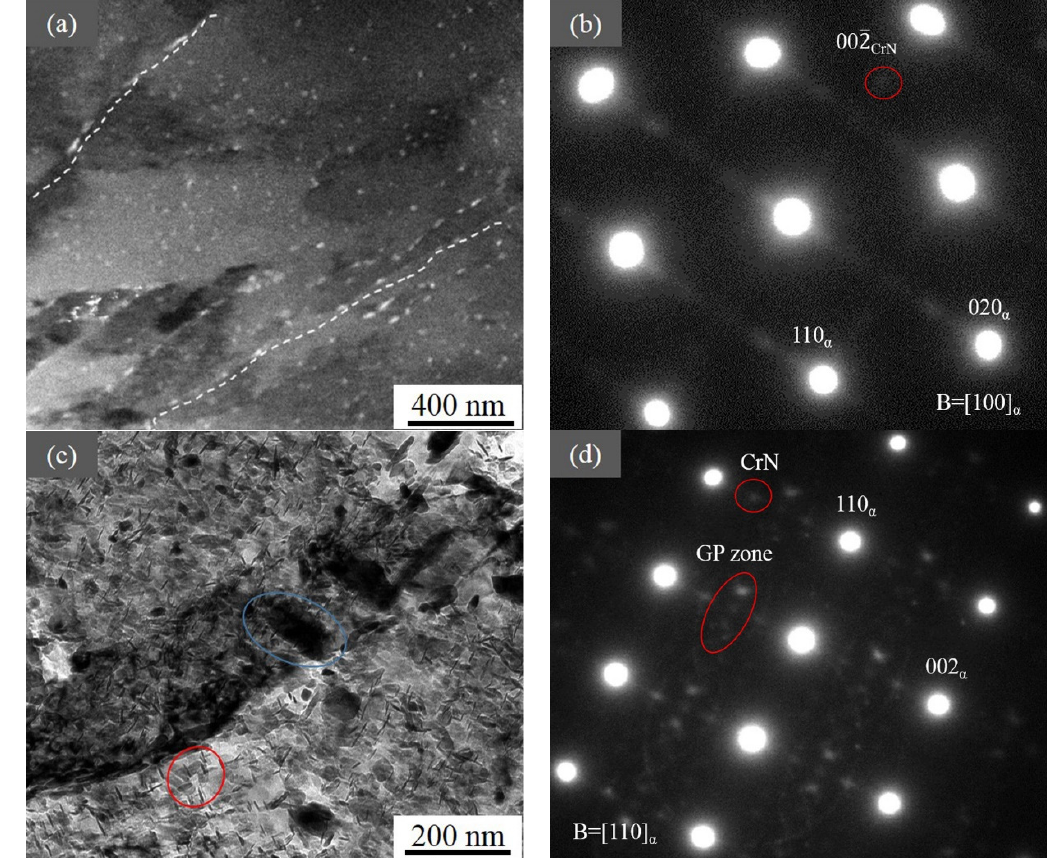
Figure 7. ( a ) TEM image of the nitrided steel at the depth of 120 µm. The white lines indicate the plate-like precipitates along the boundaries, and the corresponding SAED is shown in ( b ). ( c ) TEM image of the nitrided steel at the depth of 210 µm, as well as ( d ) corresponding SAED. In ( c ), the blue circle marks the Fe 3 C, the red one indicates GP zones and CrN, and their diffraction spots are seen in ( d ).